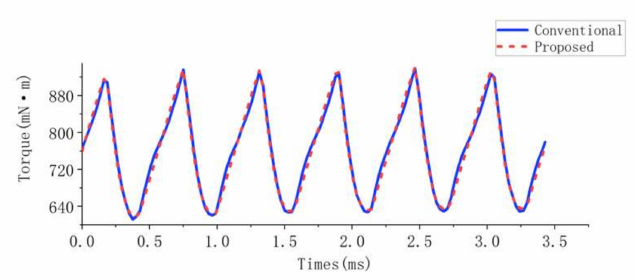
Figure 16. Output torque comparison of conventional and proposed